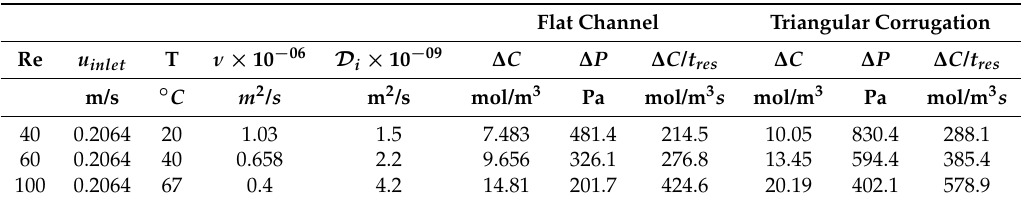
Table A3. ∆ C , ∆ P and mass transfer rate at different temperatures for flat and triangular spacer-filled channels.